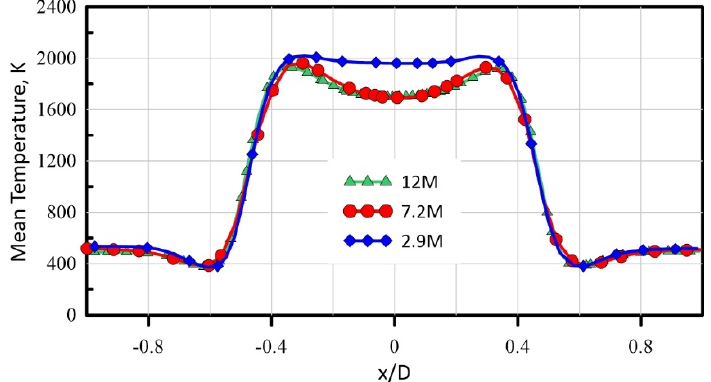
Figure A1. Mean temperature profiles depending on the mesh number of nodes, K.